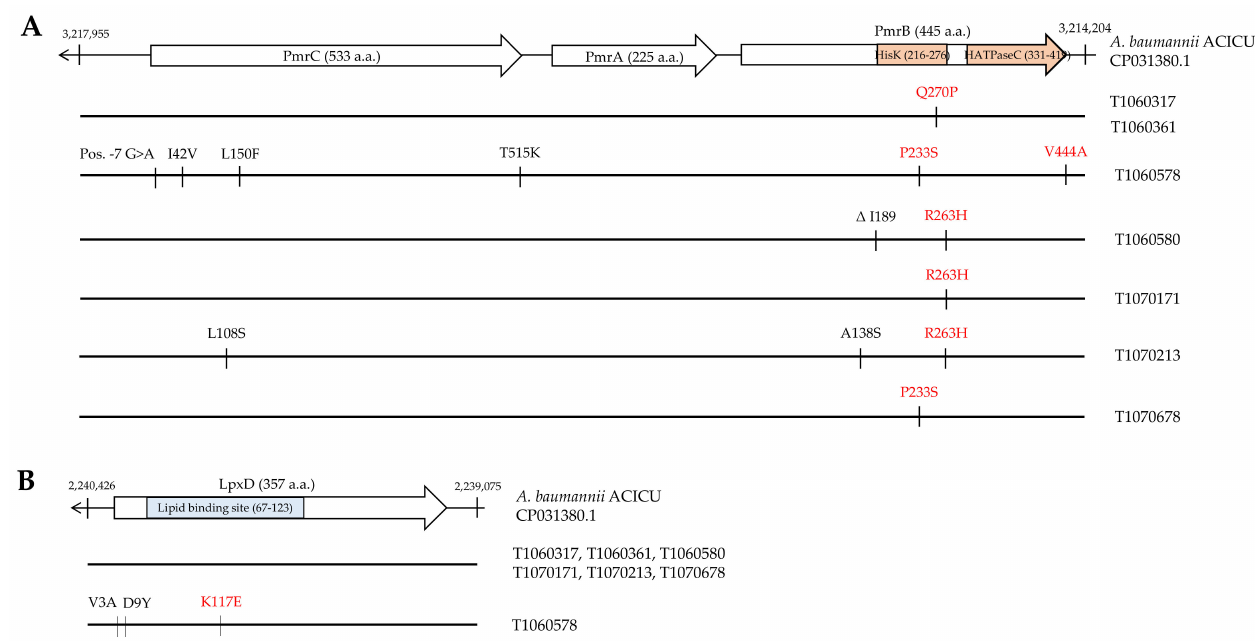
Figure 1. Amino acid substitutions in PmrC, PmrA, PmrB ( A ), and LpxD ( B ) in the CCR-AB isolates. The genetic map of the reference strain, ACICU, is displayed on the top with nucleotide numbers indicated. The open arrows depict the relevant genes with the names and size (in amino acid) shown. The functional domains in PmrB and LpxD are colored in orange and blue, respectively. Amino acid substitutions in the CCR-AB isolates are pictured below. Previously reported mutations are marked in red. Newly identified mutations are marked in